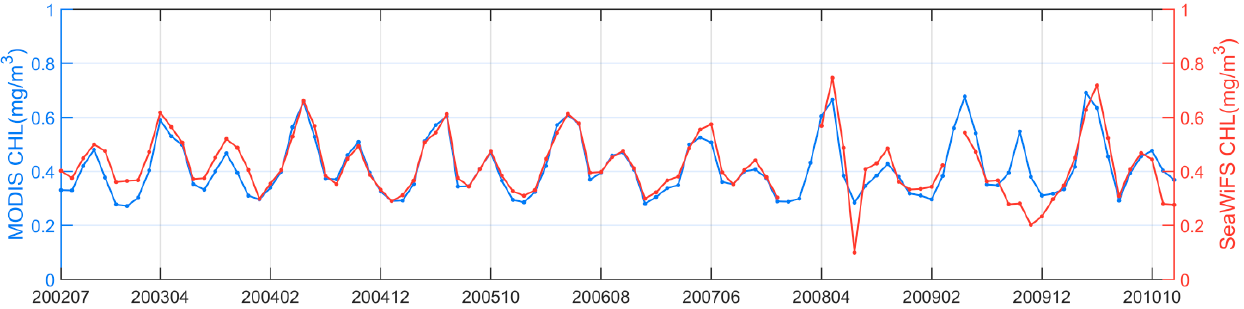
Figure 2. Time series of the monthly Chl-a in the northwest Pacific, derived from both MODIS and SeaWiFS in their overlapped observation period between July 2002 and November 2010.